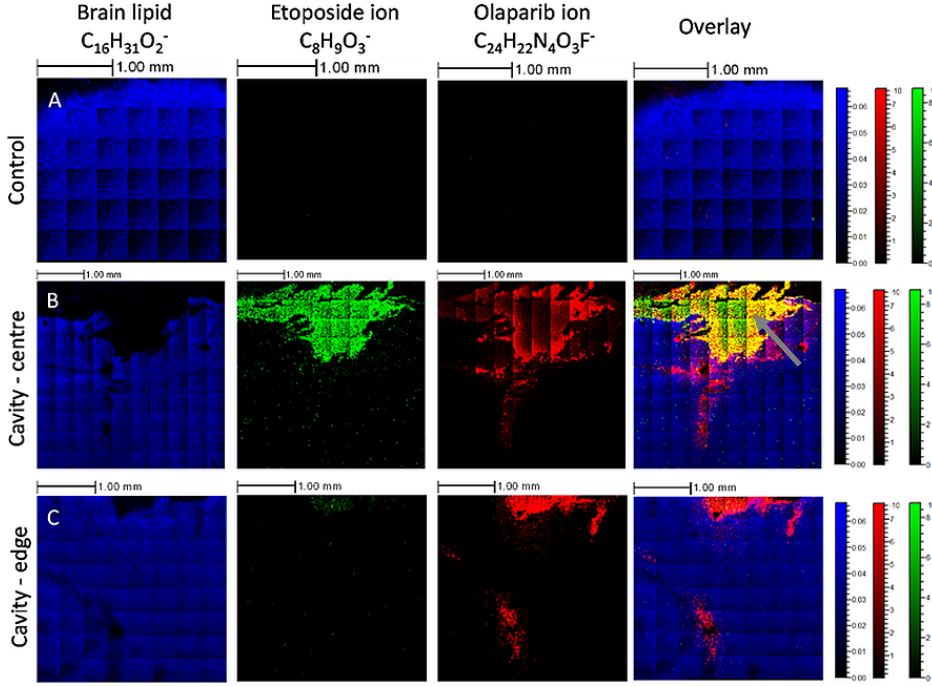
Figure 5. OrbiSIMS secondary ion images showing the location of etoposide and olaparib in ex vivo rat brain tissue following combined spray delivery into a pseudo-resection cavity. Primary ions diagnostic for the olaparib fragment C 24 H 22 N 4 O 3 F − are shown in red, etoposide fragment C 8 H 9 O 3 − shown in green and the brain lipid fragment C 16 H 31 O 2 − shown in blue, plus a combined merged image of the three ions. The secondary ions diagnostic for etoposide and olaparib are also observed to be colocalised within the yellow region (indicated by the grey arrow). Images in ( A ) are from a control slice taken from the edge of the brain distant from the cavity, ( B ) are from the central cavity and ( C ) from the cavity edge.